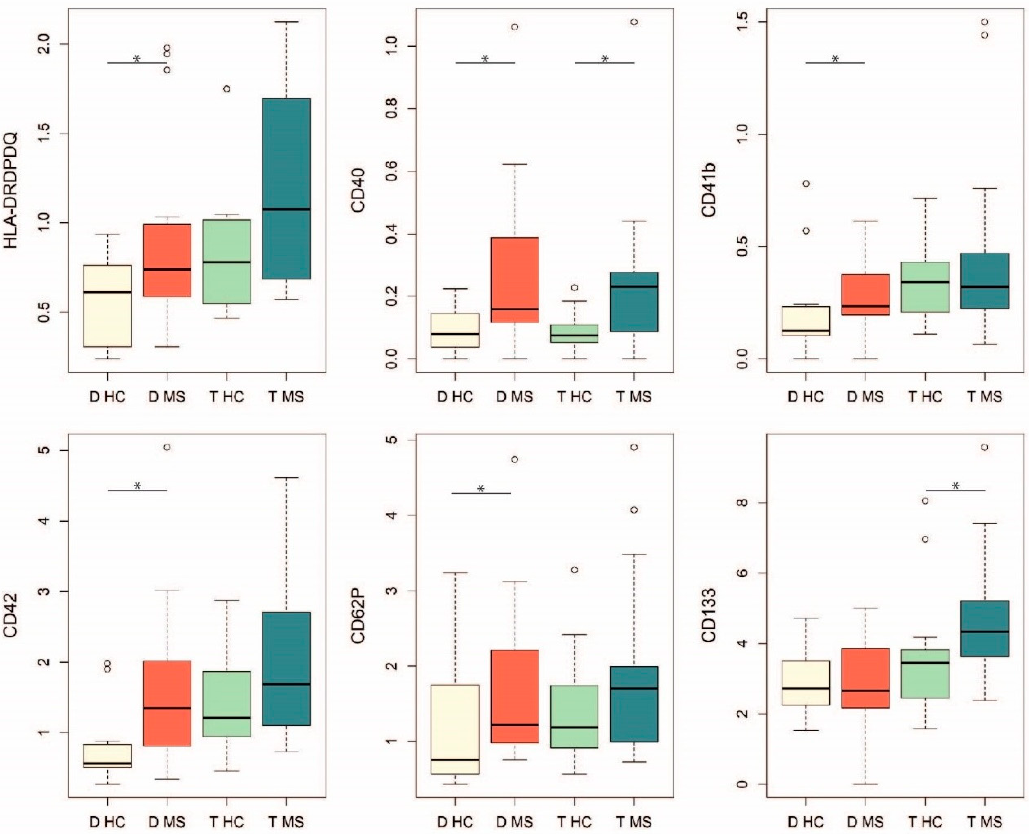
Figure 3. Surface markers differentially expressed between MS and HC groups. MFI of the marker relative to the mean value of tetraspanins’ MFI are represented. Mann–Whitney U test, * 0.01 ≤ p < 0.05.